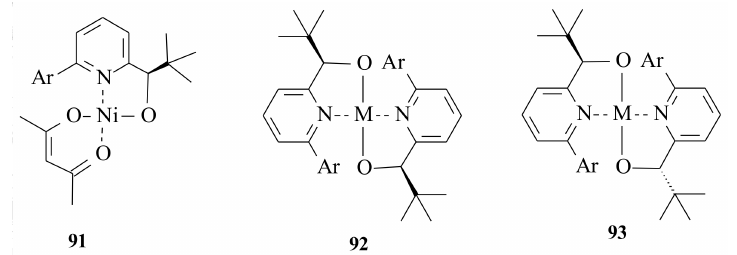
Figure 17. Intermediates proposed for the Ni-catalyzed addition reactions